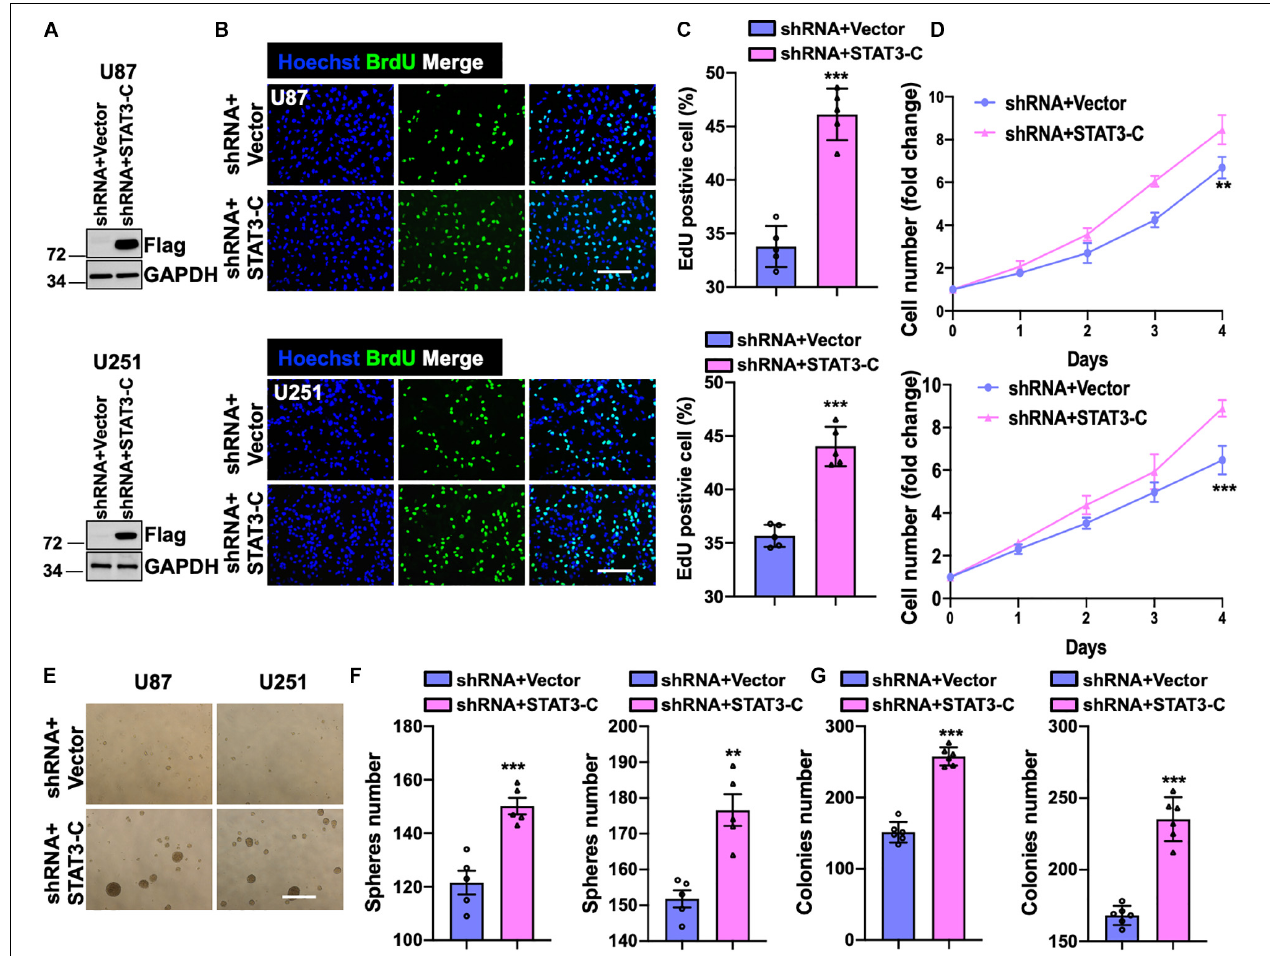
FIGURE 7 | Forced expression of STAT3 restores overexpression of SH2B3. (A) Immunoblot of indicated protein in U87 (up panel) and U251 (below panel) SH2B3 silencing cells expressing with or without STAT3-C-Flag. (B) Immunofluorescence staining of BrdU in indicated GBM cells. Scale bar = 100 µ m. (C) BrdU positive cells were quantified. (D) The cell proliferation rate of indicated GBM cells. (E) Representative images of tumor spheres derived from indicated GBM cells. Scale bar = 500 µ m. (F) The number of tumor spheres was quantified. (G) The number of colonies was quantified. *, **, and *** indicate p < 0.05, p < 0.01, and p < 0.0001, respectively.